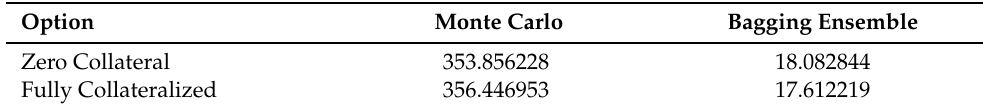
Table 11. Price surface computation time in